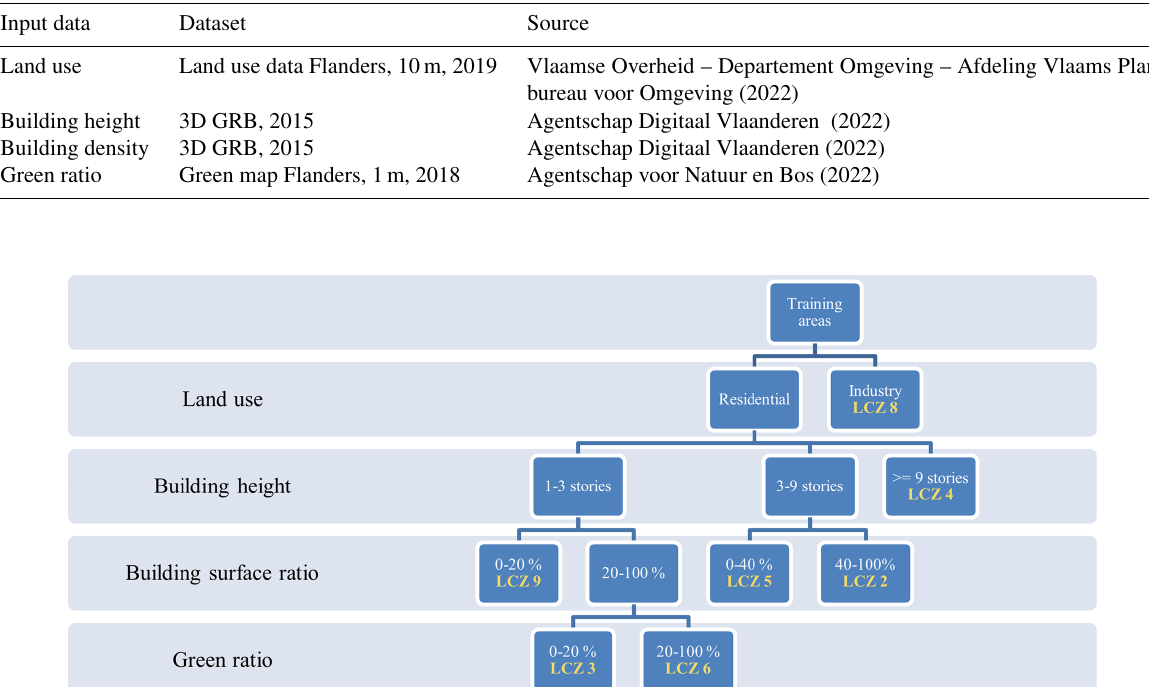
Figure B1. Decision tree used to delineate training areas for urban LCZ classes.